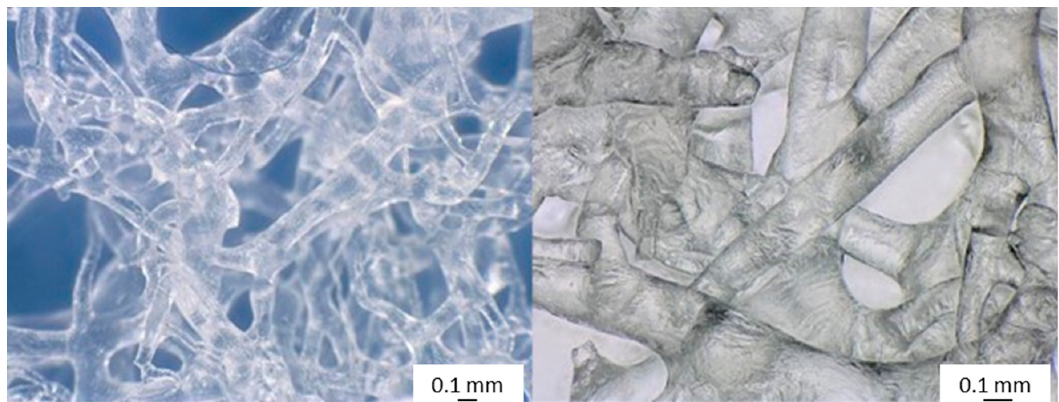
Figure 5. Ready-to-use, flat 3D chitinous scaffold isolated from I. labyrinthus remains porous and is mechanically strong enough to be manually manipulated.